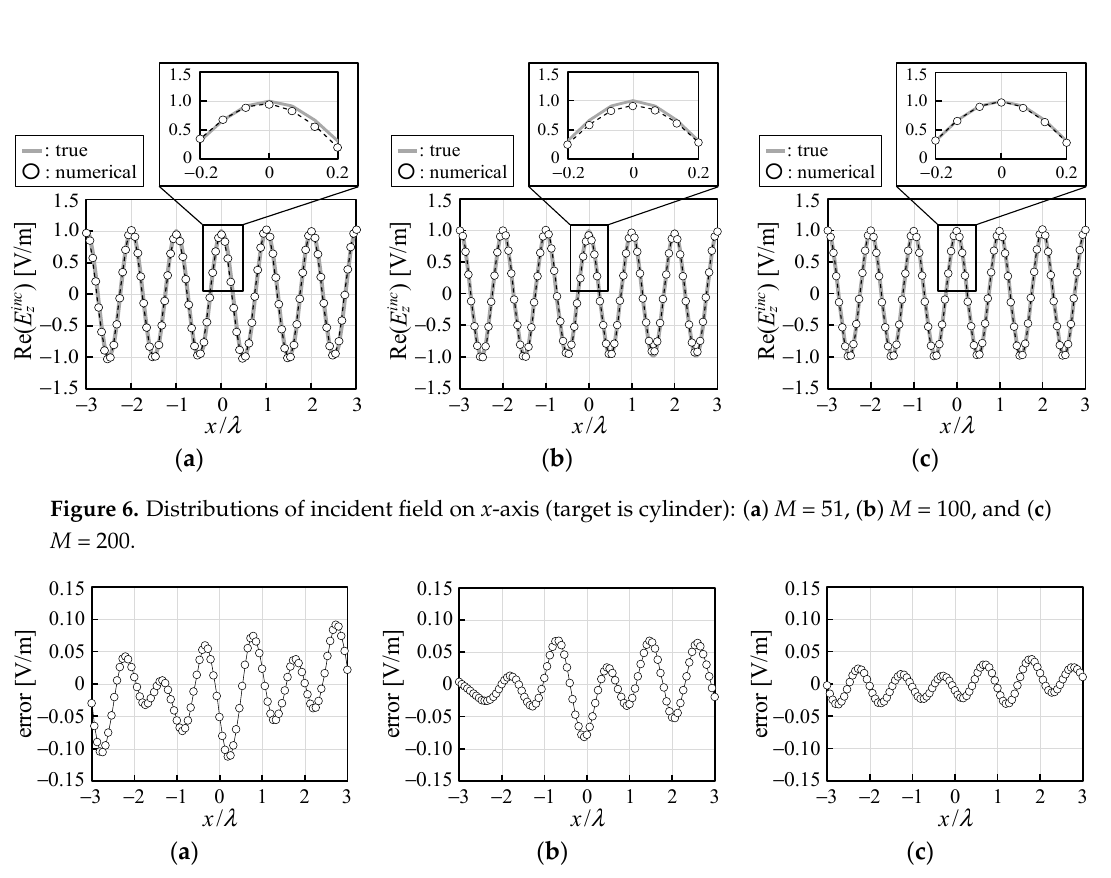
Figure 7. Error of incident field on x -axis (target is cylinder): ( a ) M = 51, ( b ) M = 100, and ( c ) M = 200. In the case of the square or L-shape object, the incident field is also successfully estimated by setting M = 200, as shown in Figures 8–10.